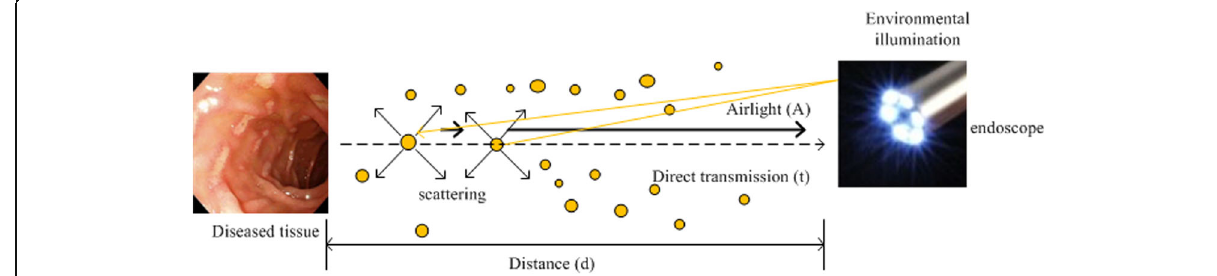
Fig. 2 Description of endoscopic imaging in the optical